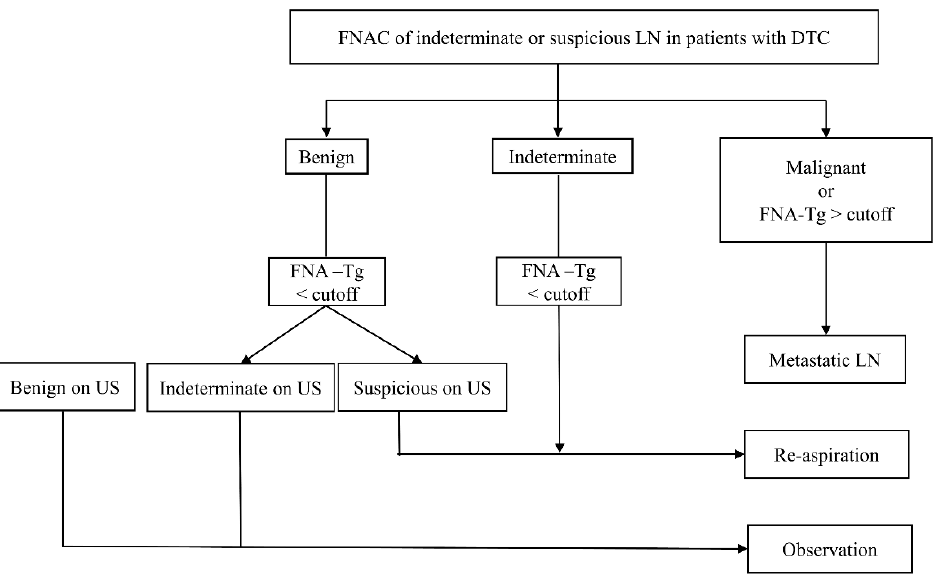
Figure 3. Diagram showing the algorithm for the diagnosis and management of metastatic LNs from DTC. DTC, differentiated thyroid carcinoma; FNA, fine-needle aspiration; LN, lymph node; Tg, thyroglobulin; US, ultrasound.